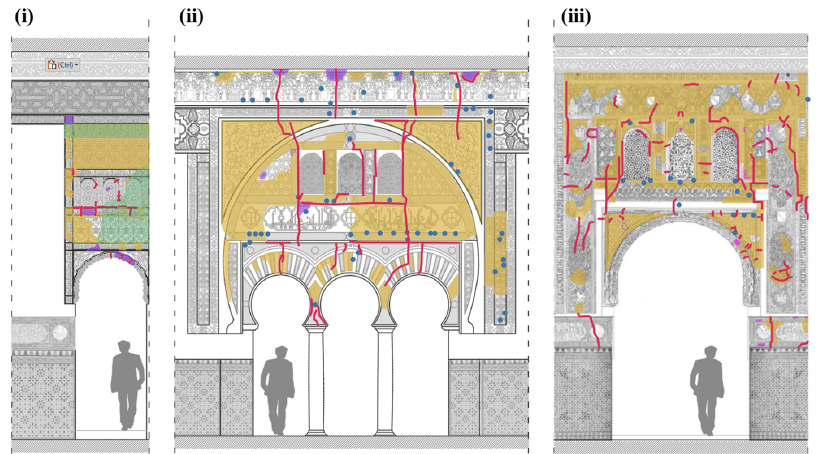
Figure 6. Mapping anomalies in three cases of study.